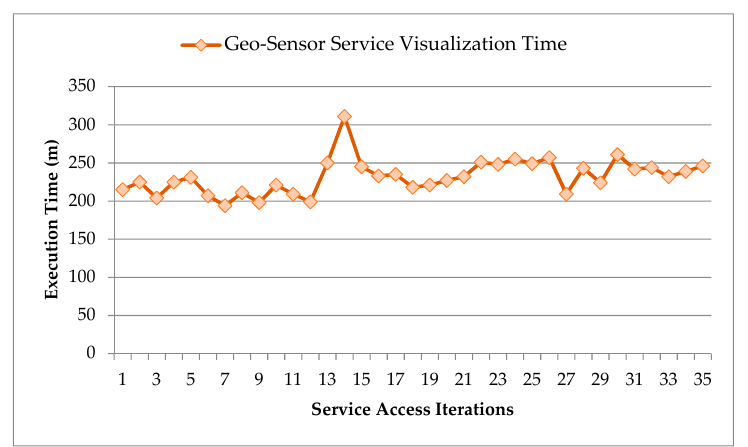
Figure 13. Execution time for geo-sensor service visualization and access request.